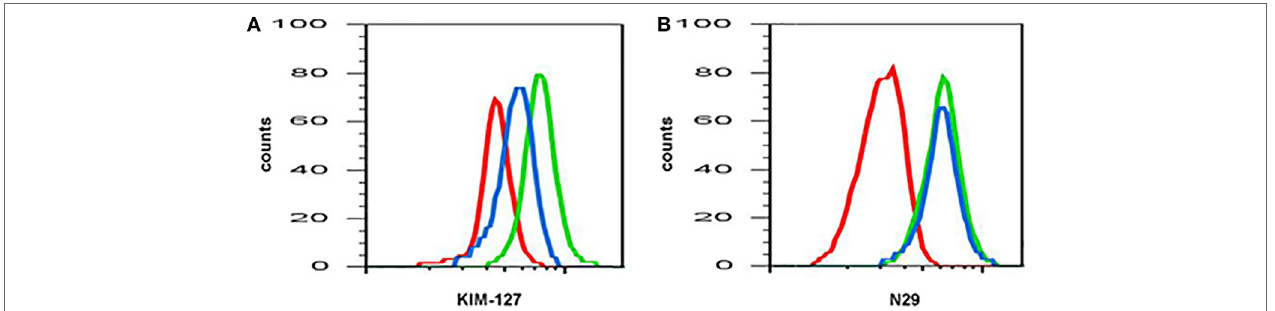
FiGURe 1 | Anti-interleukin (IL)-5 (mepolizumab) decreases β 2 but not β 1 integrin activation on blood eosinophils. Reactivity of monoclonal antibody (A) KIM-127 (to the intermediate-activity state of β 2 integrin), and (b) N29 (to the intermediate-activity state of β 1 integrin) on blood eosinophils before (green) and after (blue) anti-IL-5 mepolizumab administration. Red, isotype control. A representative subject with mild allergic asthma from Ref. (34).